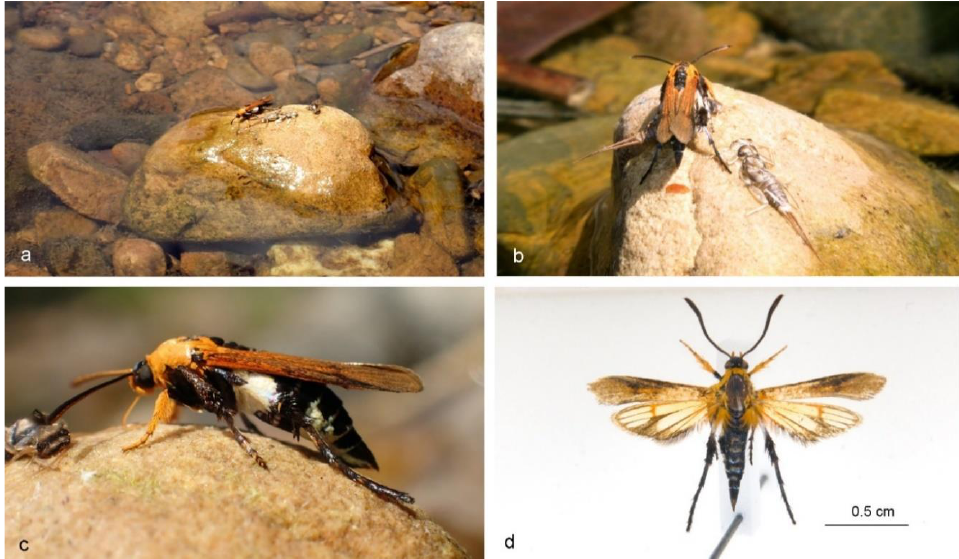
Figure 1. Aurantiosphecia piotrii sp. nov . is an orange, black and white braconid wasp mimic. ( a ) The sesiid was found sucking up liquids on a rock surrounded by water, on a river bank in Thailand. ( b ) It puddled on Plecoptera exuviae and ejected a brown liquid waste during the process. ( c ) A. piotrii sp. nov. has long, skinny, wasp-like hind legs and matching white colouration of the hind tibia and abdomen which gives an impression of a “wasp waist”. ( d ) A. piotrii sp. nov. holotype, pinned.